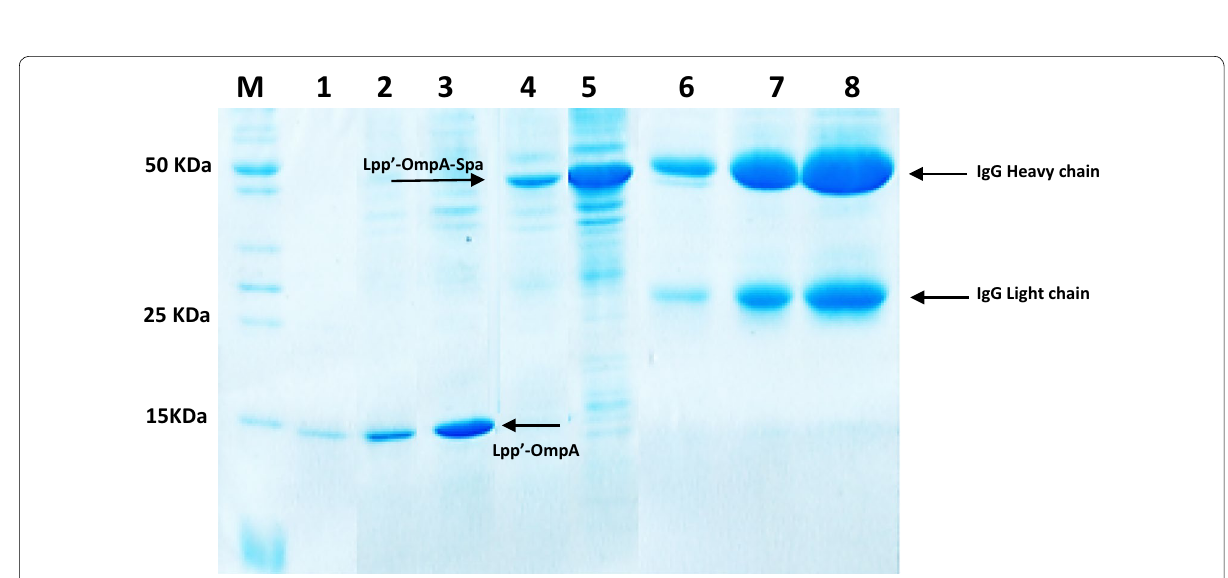
Fig. 5 SDS-PAGE analysis showing efficiency of E. coli Lpp ′ -ompA-SpA compared to the Protein A-agarose, stained by Coomassie Brilliant Blue R. M:Protein marker, 1–3: different concentrations of expressed recombinant Lpp ′ -ompA was loaded, 4–5: different concentrations of expressed recombinant Lpp’-ompA-Spa was loaded, 6–7: different concentrations of the purified rabbit IgG from serum using recombinant E. coli Lpp ′ -ompA-SpA after elution was loaded, 8: purified rabbit IgG from serum using protein A-agarose as a